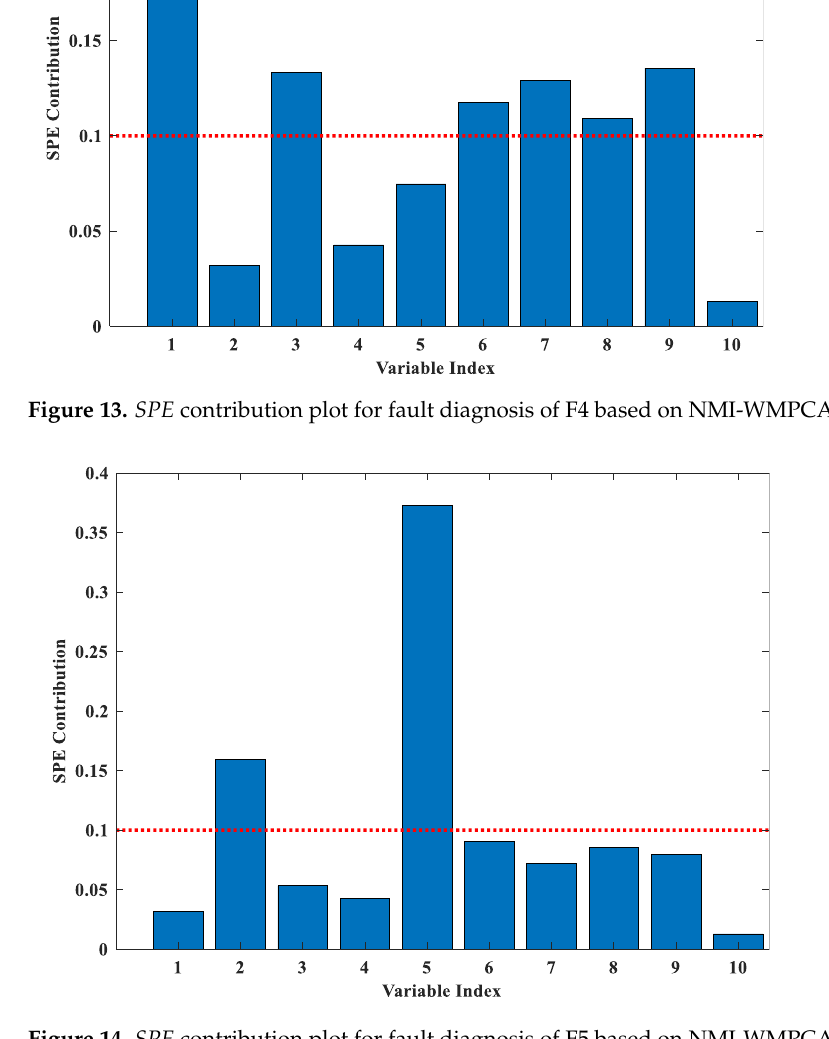
Figure 14. SPE contribution plot for fault diagnosis of F5 based on NMI-WMPCA.